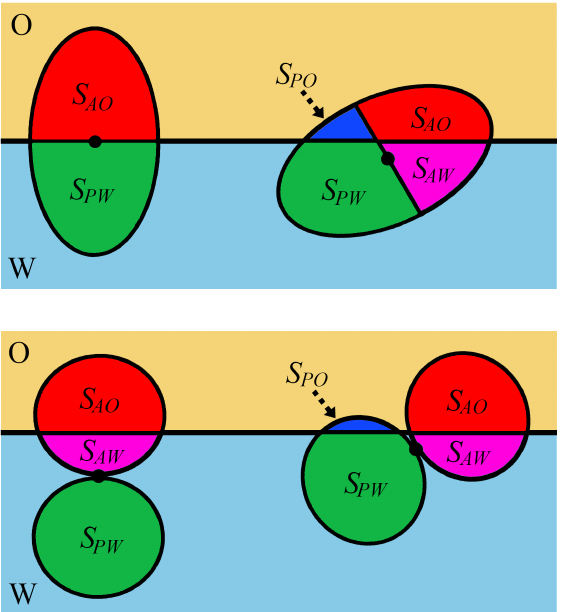
Figure 5. Examples of the configuration of Janus symmetrical ellipsoids ( upper panel ) and sym- metrical dimers ( bottom panel ) at a fluid/fluid (O/W) interface. In the case of pinned (unpinned) configuration, the particle center lies at the interface (inside a bulk phase). For an upright configura- tion, the main axis of the particle is perpendicular to the interface, else a configuration is classified as tilted. Areas of four different particle–fluid interfaces are shown: S PW for a polar region in contact with the fluid W (green), S PO for a polar region in contact with the fluid O (navy), S AO for an apolar region in contact with the fluid O (red), and S AW for an apolar region in contact with the fluid W